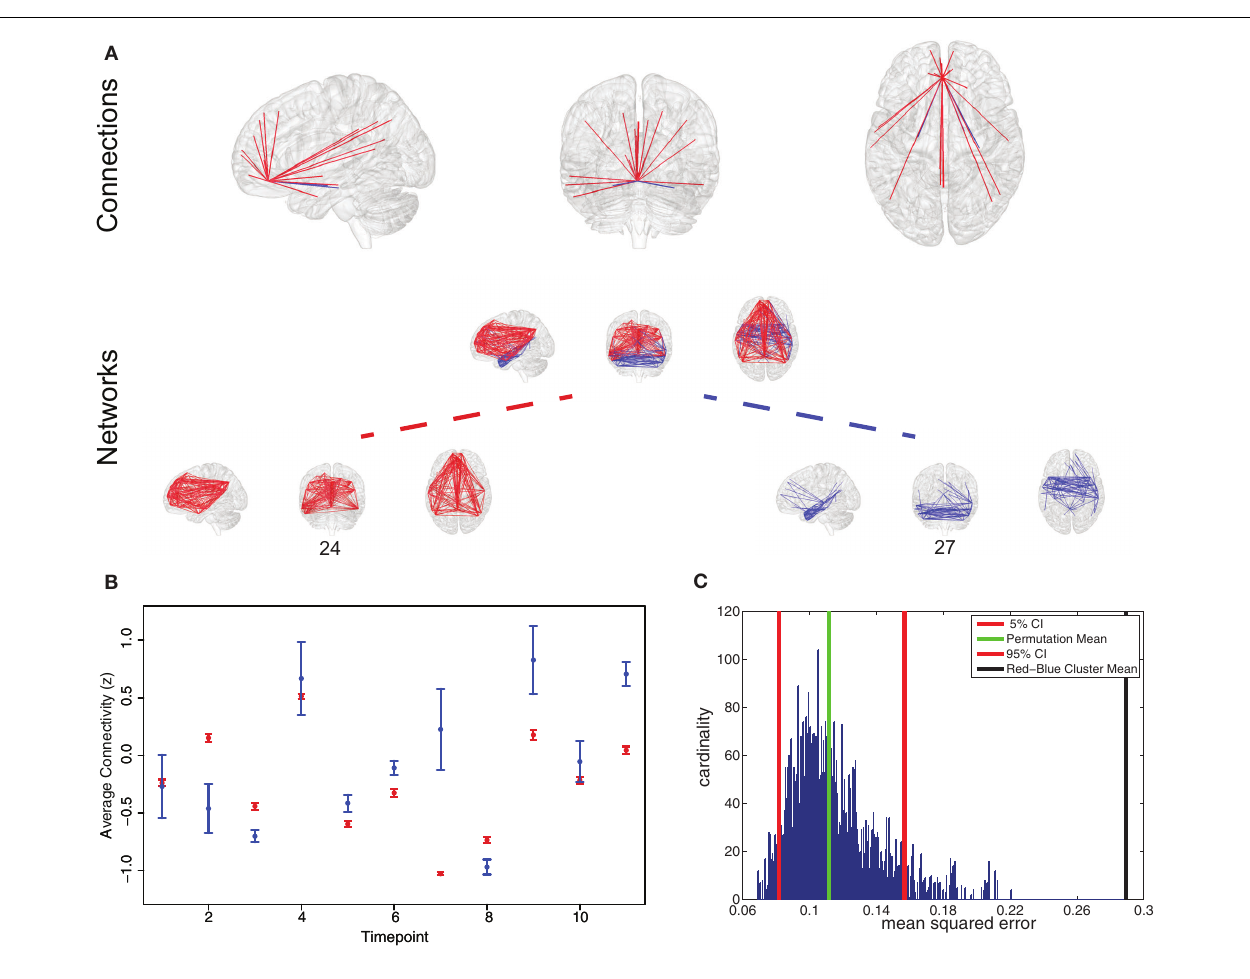
FIGURE 5 | Representative region for variation of network participation. (A) Anterior cingulate cortex (ACC) participating in two networks (networks 24 and 27). (B) Example plot of ACC participation in the two networks in a 50s interval. Timepoint 2 and 7 are good